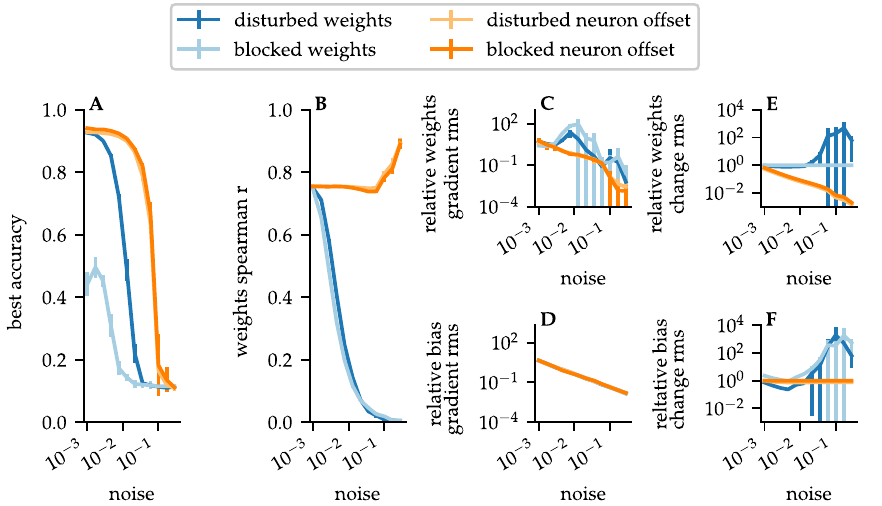
Figure 5. Experiments with disturbed learning for a uniform 1194 . Shown are results for blocked or disturbed weights or neuron offset. Error bars show standard deviation over ten independent random iterations. ( A ) Best accuracy in relation to the added noise. ( B ) Spearman R between the trained and untrained weights in relation to the added noise, to show the similarity of the weights. The effective value of the weight ( C ) and neuron offset ( D ) gradients relative to the noise demonstrates the relation of gradients to the added noise, to show the effective change per step. The relative, effective weights ( E ) and neuron offset ( F ) change shows the development of the RMS value related to the noise, to illustrate the change over the complete